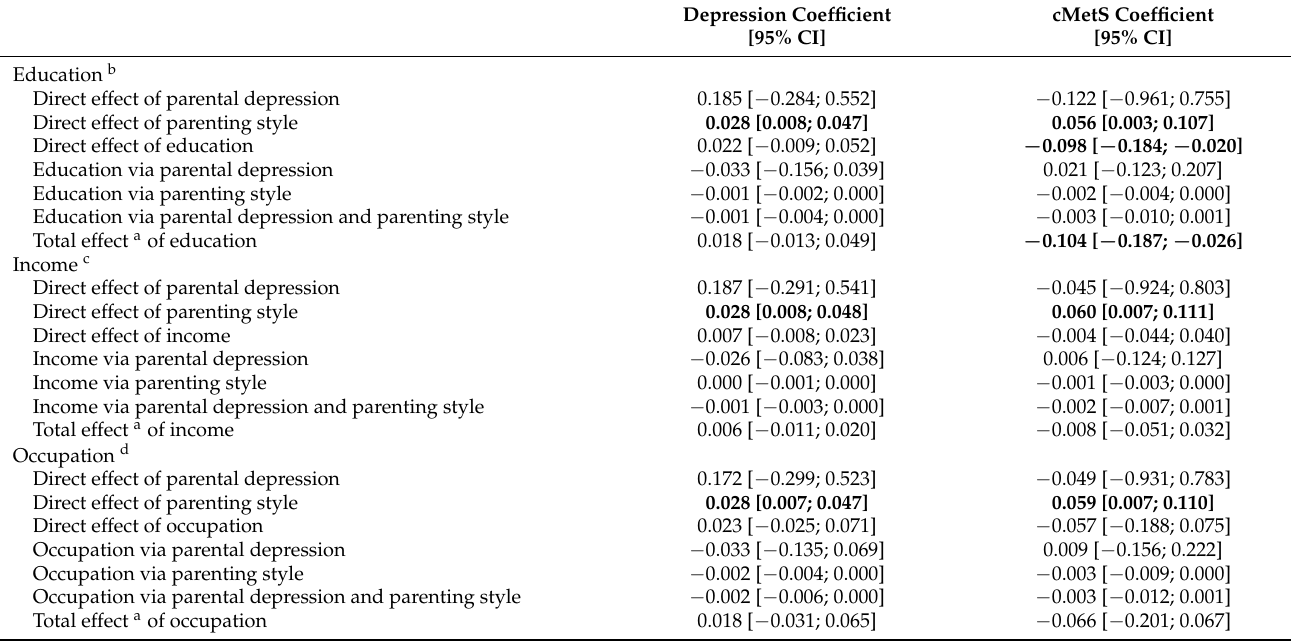
Table 3. The estimated effects of SES, parental depression, and parenting style on depression and cMetS at baseline. Statisti- cally significant effects ( p < 0.05) are bolded. Estimates for all the paths shown in Figure 1a can be seen in Supplementary Figure